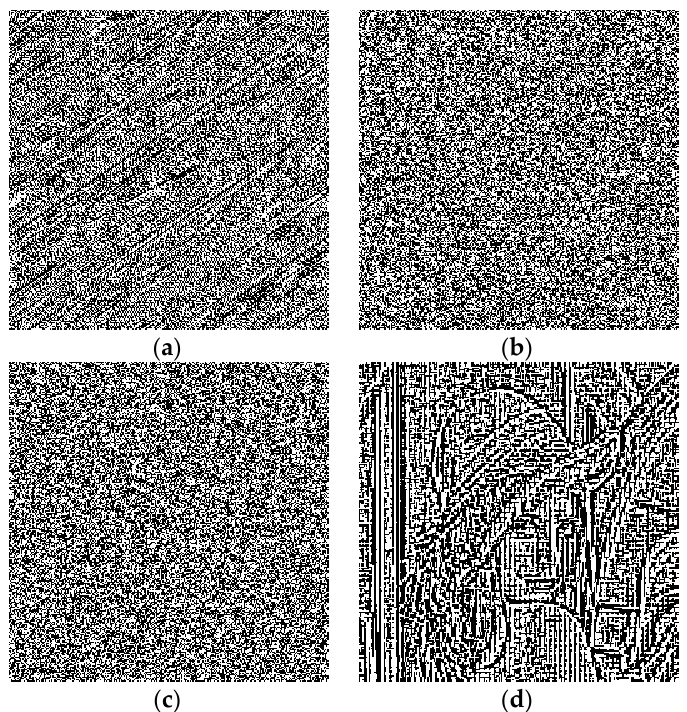
Figure 10. Extracted binary watermarks with different key combinations: ( a ) k 1 = 75, k 2 = 30; ( b ) k 1 = 70, k 2 = 32; ( c ) k 1 = 32, k 2 = 75; ( d ) k 1 = 75, k 2 =